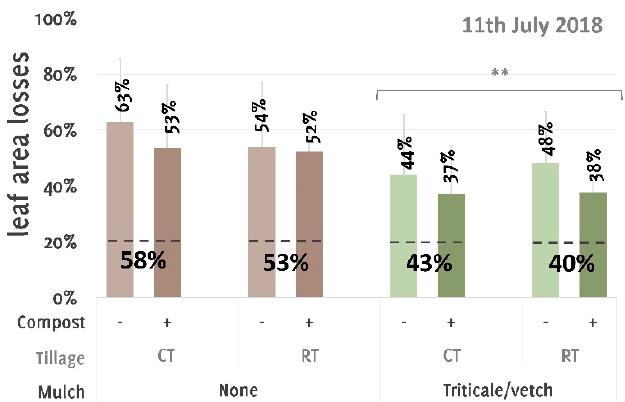
Figure 5. Leaf area losses of the 2018 trial on 9 July in the treatments with (+) and without ( − ) compost under conventional (CT) and reduced (RT) tillage as well as unmulched (none) and mulched (triticale/vegetation). Relative numbers below the dashed lines indicate mean values of the marked variants. Lines above the bars indicate the standard deviation in positive direction. Statistical differences (LME) are marked with ** ( p < 0.001).